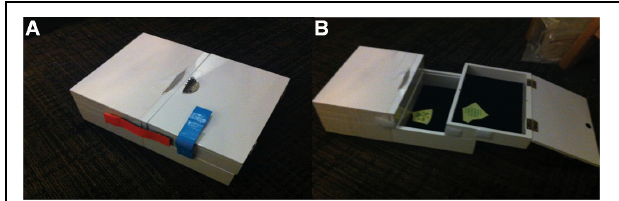
FIGURE 1 | Problem box task. (A) Closed problem box showing the two defenses (blue and red). (B) Opened problem box showing both upper and lower